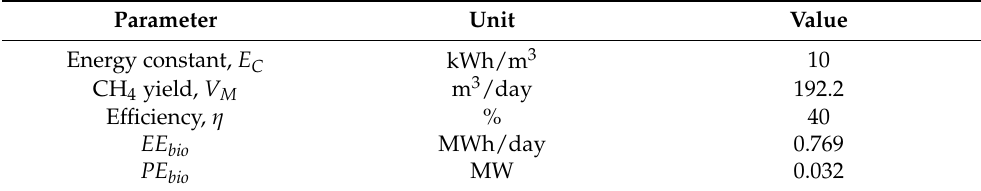
Table 1. Electricity potential from the generated biogas.